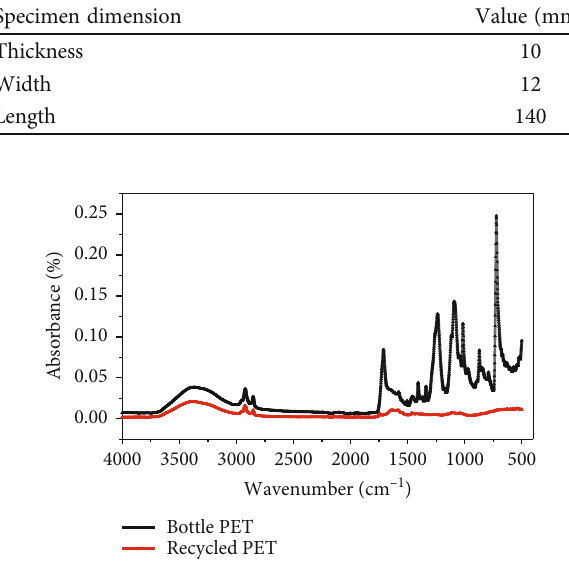
Table 1: Proportion of the mixtures using mixture optimal design of expert and sample codes.